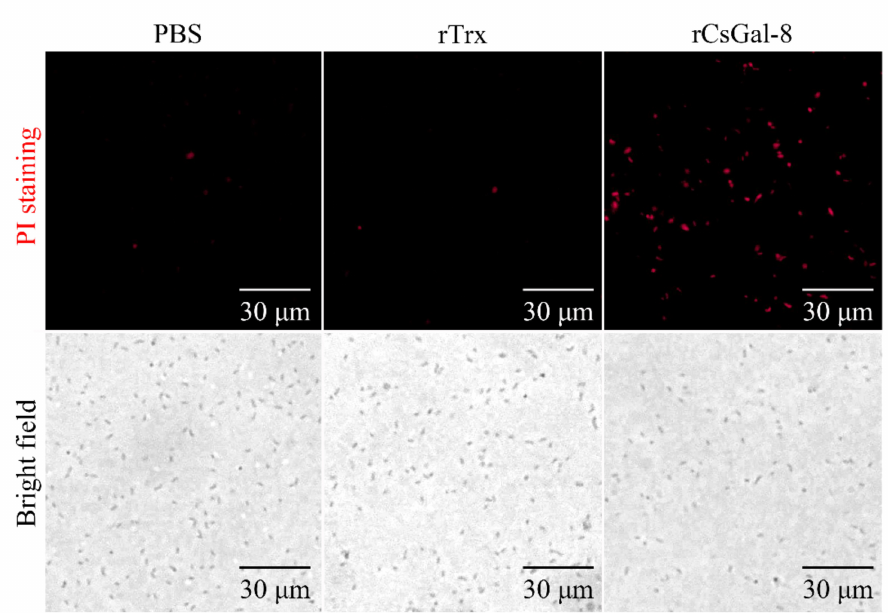
Figure 9. Propidium iodide staining analysis of bactericidal activity of rCsGal-8. Vibrio anguillarum were incubated with 1 µ M rCsGal-8 or rTrx or PBS (control) for 30 min. Following the 30 min incuba- tion, bacteria were stained with propidium iodide and observed under a fluorescence microscope.